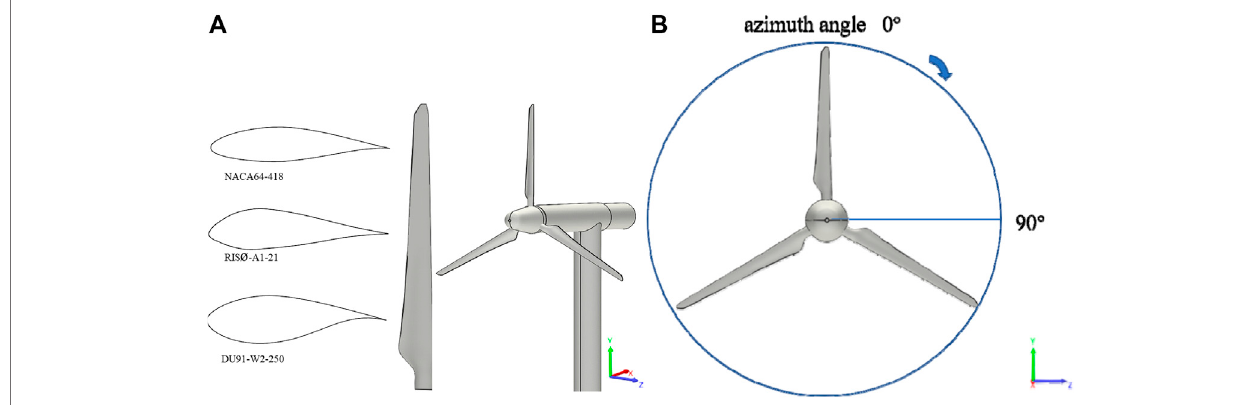
FIGURE 1 | Geometry of the MEXICO wind turbine: (A) blade airfoil and turbine model; (B) diagram of the blade azimuth angle.